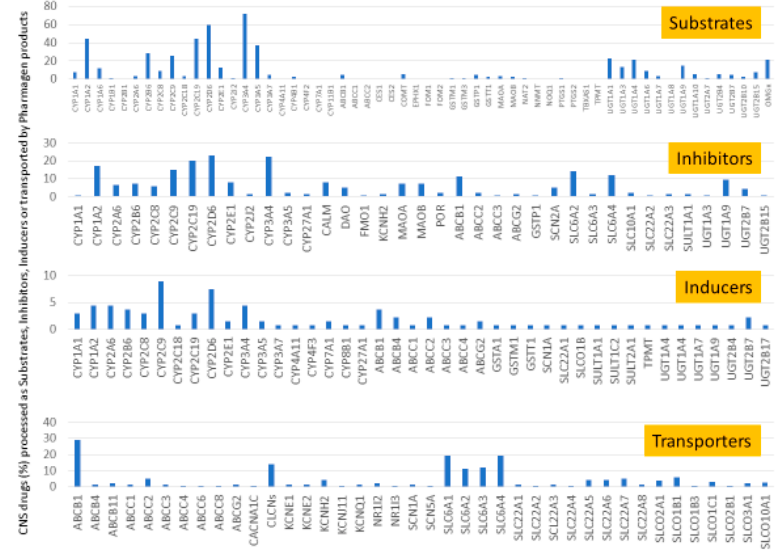
Figure 3. Substrates, inhibitors, inducers, and transporters of 307 CNS drugs (antidepressants, anxiolitics, hipnotics, sedatives, antipsychotics, antiepileptics, antiparkinsonian, and anti-dementia drugs).